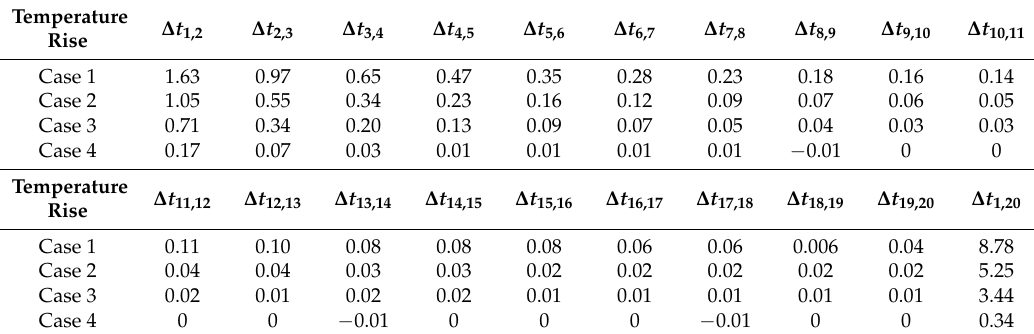
Table 4. Soil temperature rises of 4 cases.